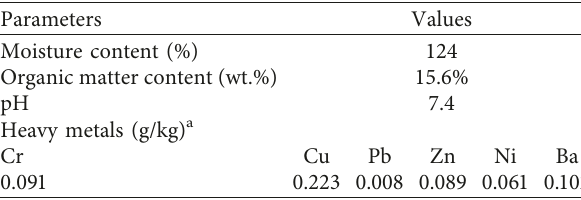
Table 1: Physicochemical properties of dredged sludge used.